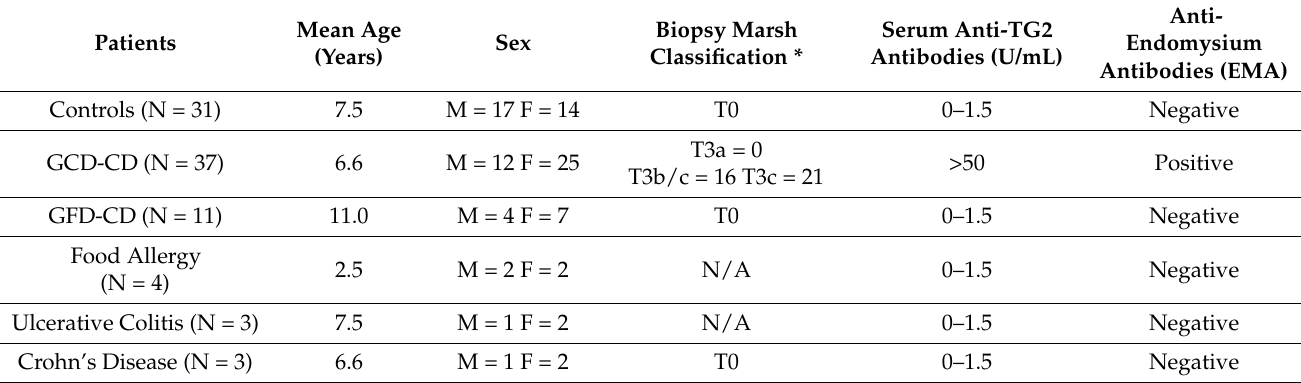
Table 1. Clinical data of patients and